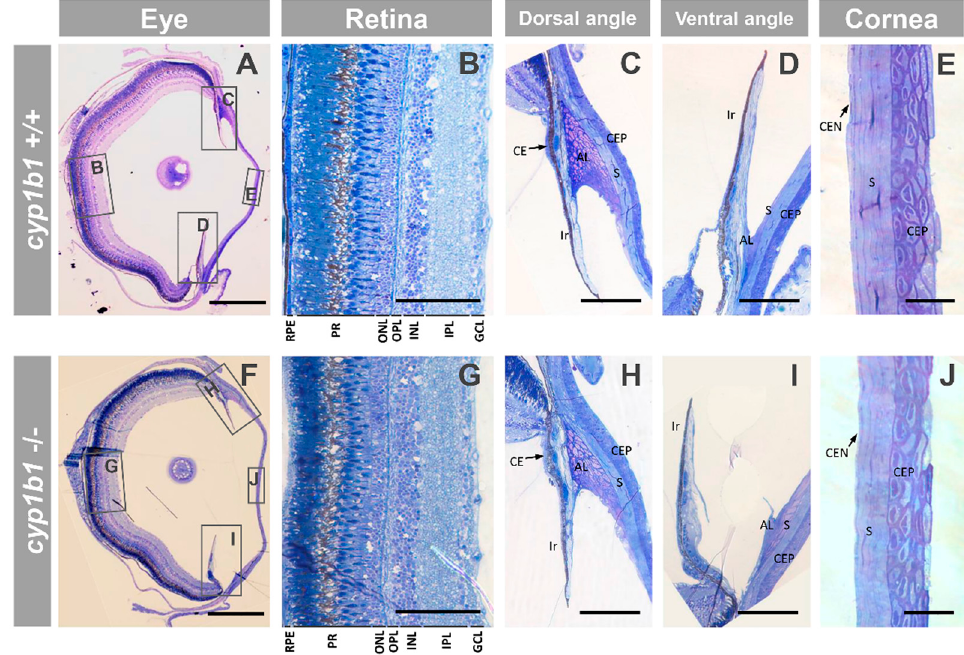
Figure 6. Ocular histology of adult (seven months) cyp1b1 -KO zebrafish with Ph2 craniofacial alterations (F3). ( A – J ) Semithin (500 nm) tissue sections were stained with toluidine blue. The squares and rectangles indicate the areas of the images magnified in the indicated panels. No significant differences were observed between the eyes of wildtype and cyp1b1 -KO zebrafish siblings. Scale bar in ( A , F ): 500 µm. Scale bar in ( B – D , G – I ): 100 µm. Scale bar in ( E , J ): 25 µm. RPE: retinal pigment epithelium; PR: photoreceptors; ONL: outer nuclear layer; OPL: outer plexiform layer; INL: inner nuclear layer; IPL: inner plexiform layer; GCL: ganglion cell layer; CE: ciliary epithelium; AL: annular ligament; CEP: corneal epithelium; CEN: corneal endothelium; S: stroma. The images are representative of the results observed in three fishes of each genotype. Three tissue sections per eye were analyzed.